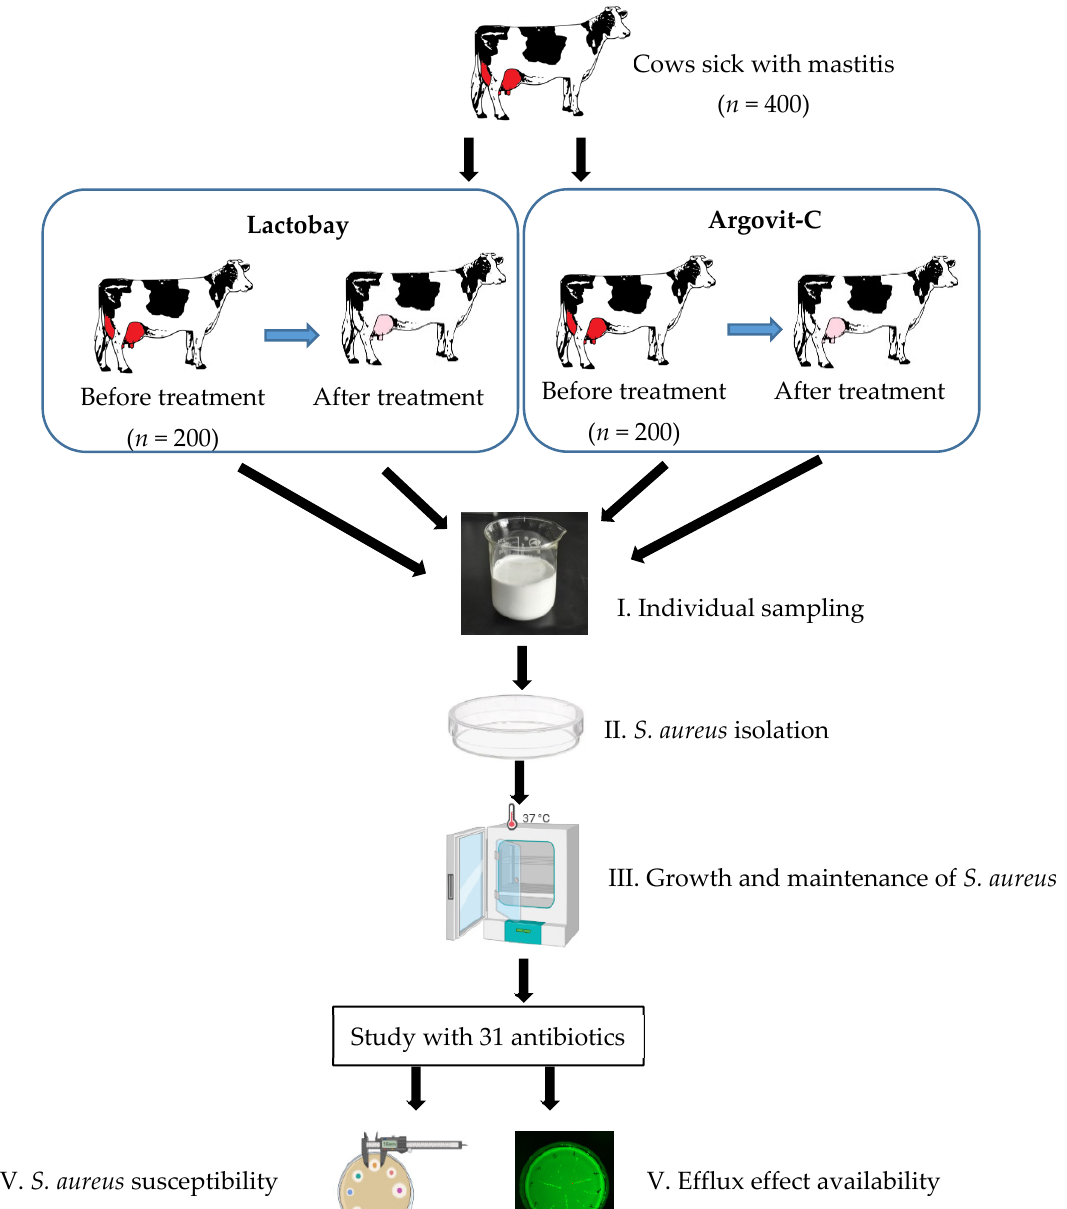
Figure 1. Experimental design diagram. Sampling (I), S. aureus isolation (II), S. aureus propagation (III), subsequent studies of antibiotic susceptibility (IV) and efflux effect (V) were carried out before and after treatments with Lactobay or Argovit-C.